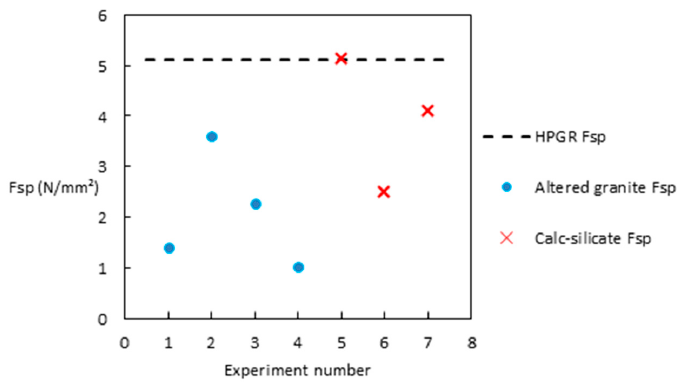
Figure 2. The compression strength test was performed in order to determine the optimal specific pressing force for all pressing force for all tests.